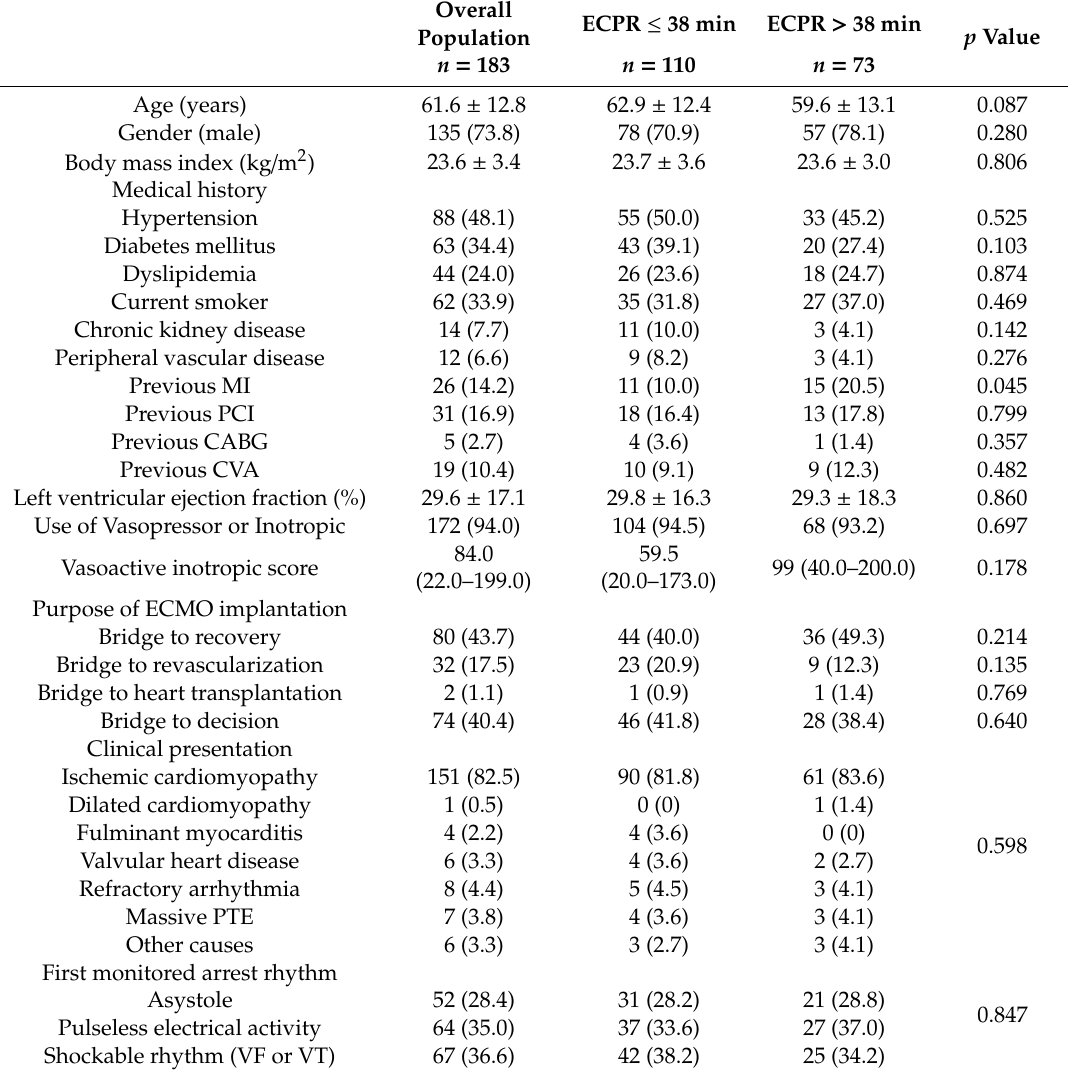
Table 1. Baseline, arrest, and resuscitation